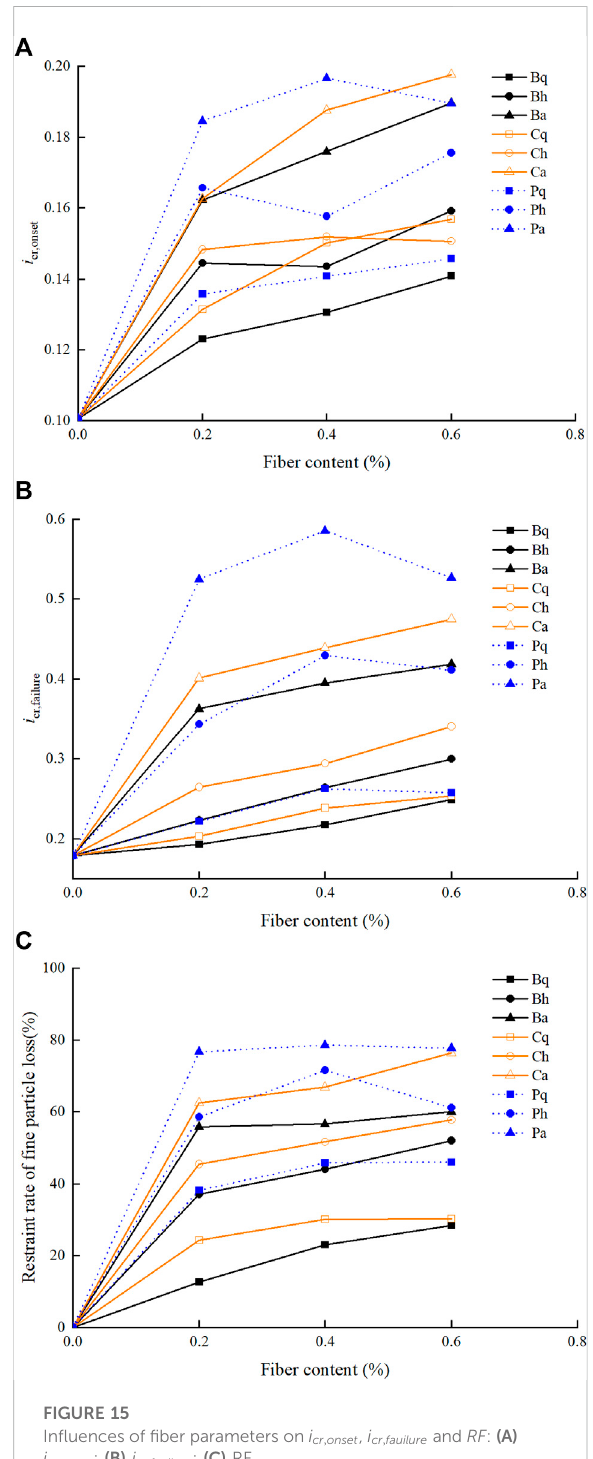
FIGURE 15 In fl uences of fi ber parameters on i cr , onset , i cr , fauilure and RF : (A) i cr i cr , onset ; (B) , fauilure ; (C)